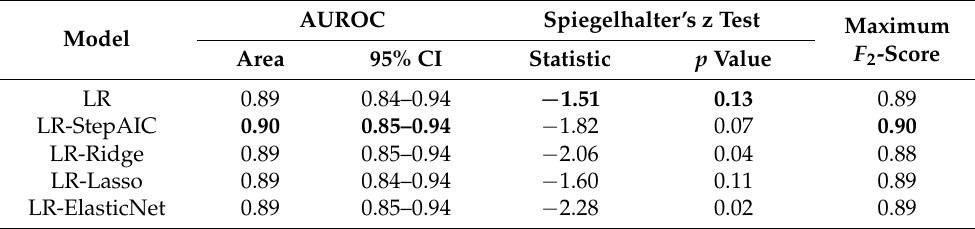
F 2 -ScoreArea 95% CI Statistic p Value